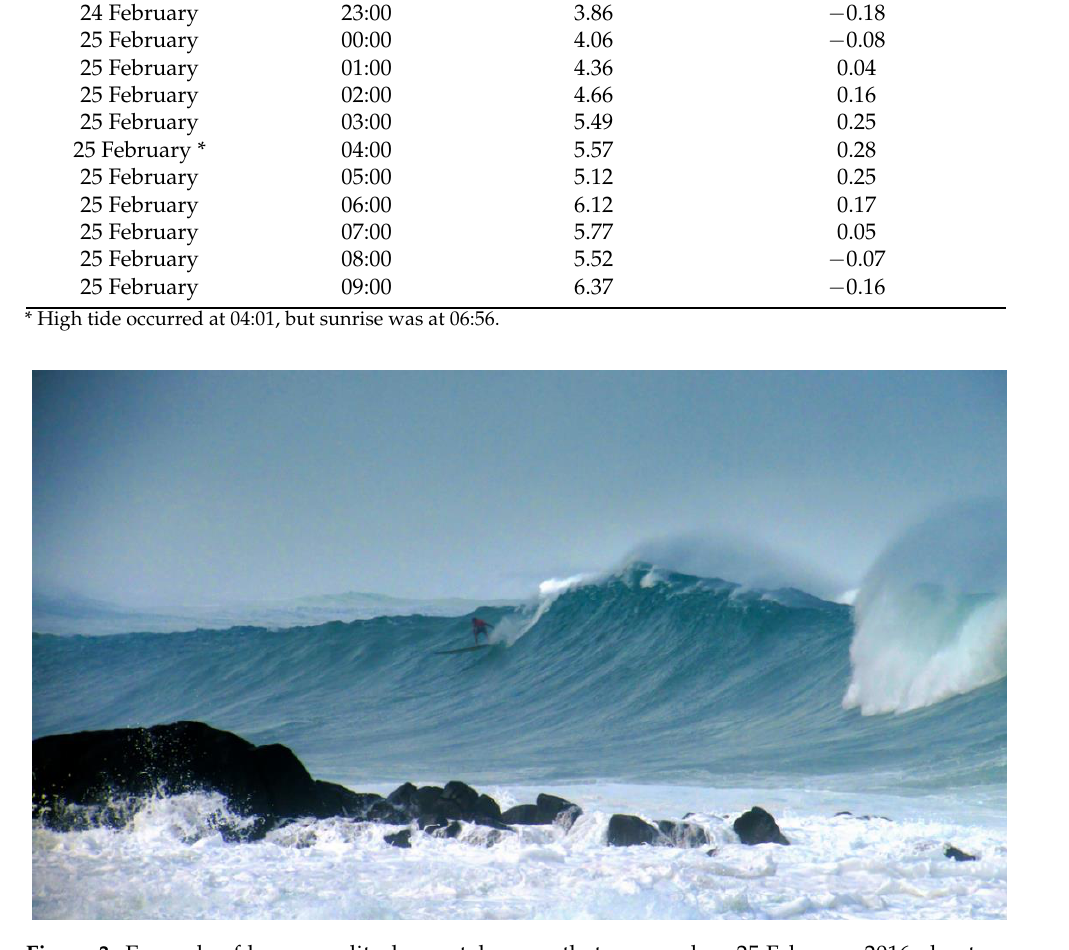
Figure 3. Example of large amplitude coastal waves that occurred on 25 February 2016, due to a strong ENSO-induced low-pressure system.